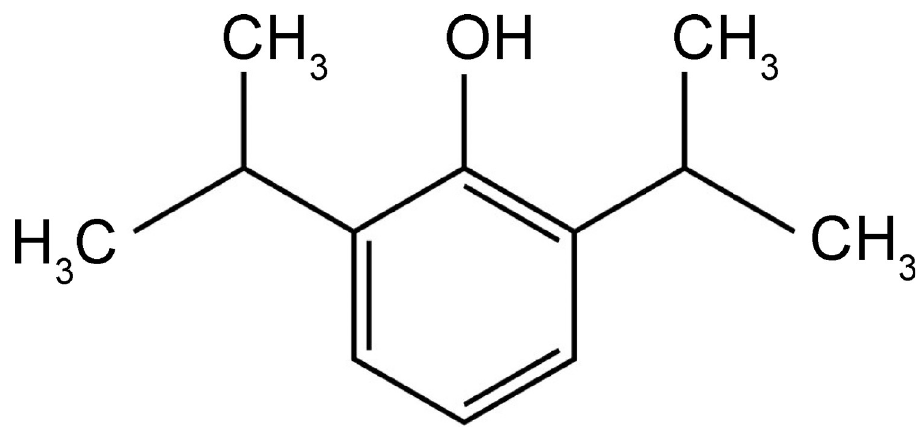
Fig 1. Chemical structure of propofol